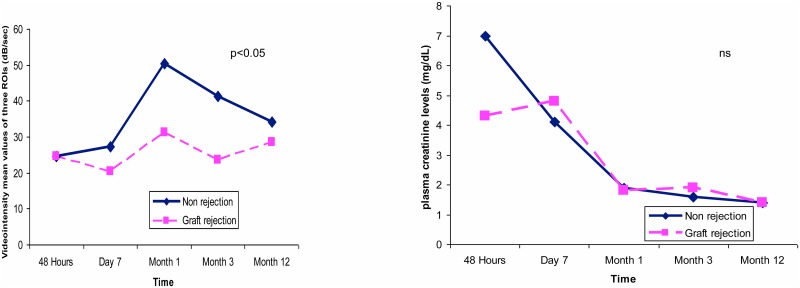
In the left panel, the CCBF values for patients with (green) and with no acute rejection demonstrate significant differences by mixed model analysis over time. In contrast, plasma creatinine levels (right panel) exhibited no differences for the same patients.